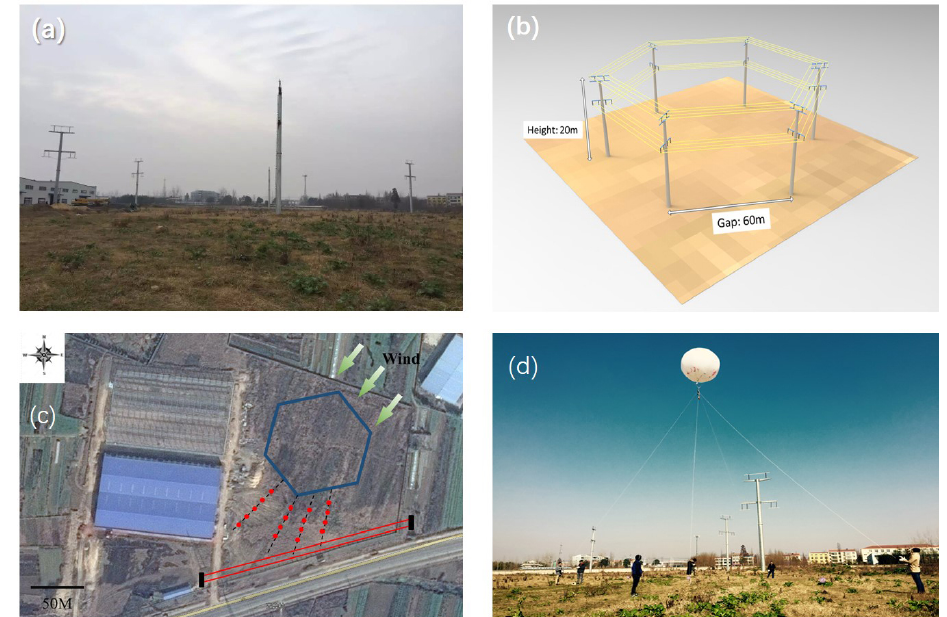
Figure 1. Large-scale installation of ion generation for the precipitation of atmospheric aerosols using over 300000 corona plasma discharges. (a) The large-scale corona discharge system consists of six poles and 7.2km electric wires. (b) The design diagram of the hexagonal discharge arrays. (c) A satellite image of the test zone (taken from https://map.baidu.com, last access: 29 December 2019). The hexagon shows the corona plasma discharge system. The red points show the locations of ion density measurements. (d) The hydrogen balloon carried the ion density measurement